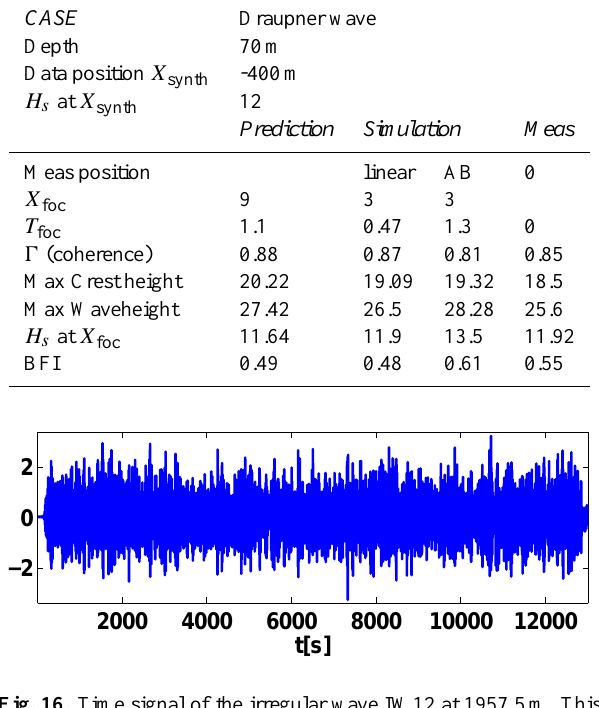
Fig. 16. Time signal of the irregular wave IW12 at 1957.5m. This isa measured signal that will be used to forecast the freak wave downstream.